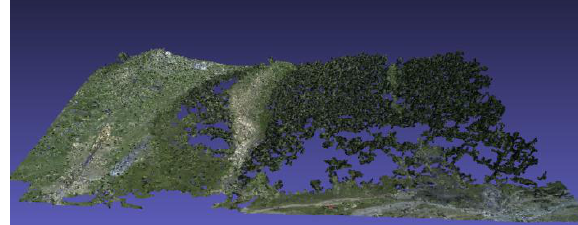
Figure 4.cloud point generated by pmvs